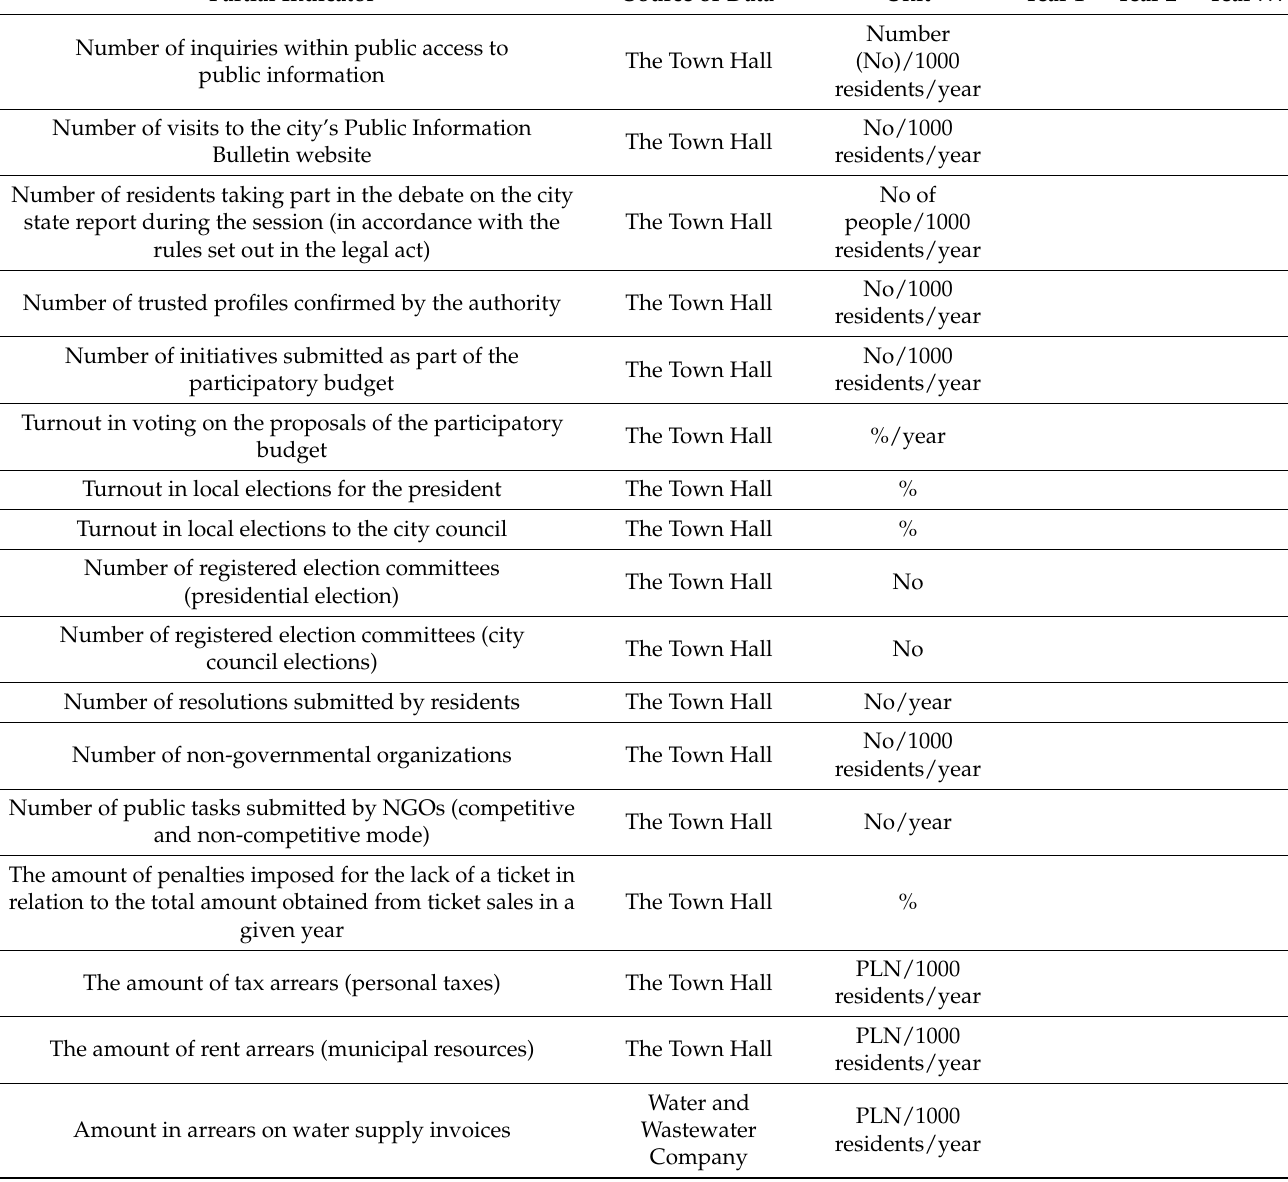
Table 5. Area 4 on civic awareness, public and social services, and efficient and transparent administration. The measure— “informed citizens and public and social